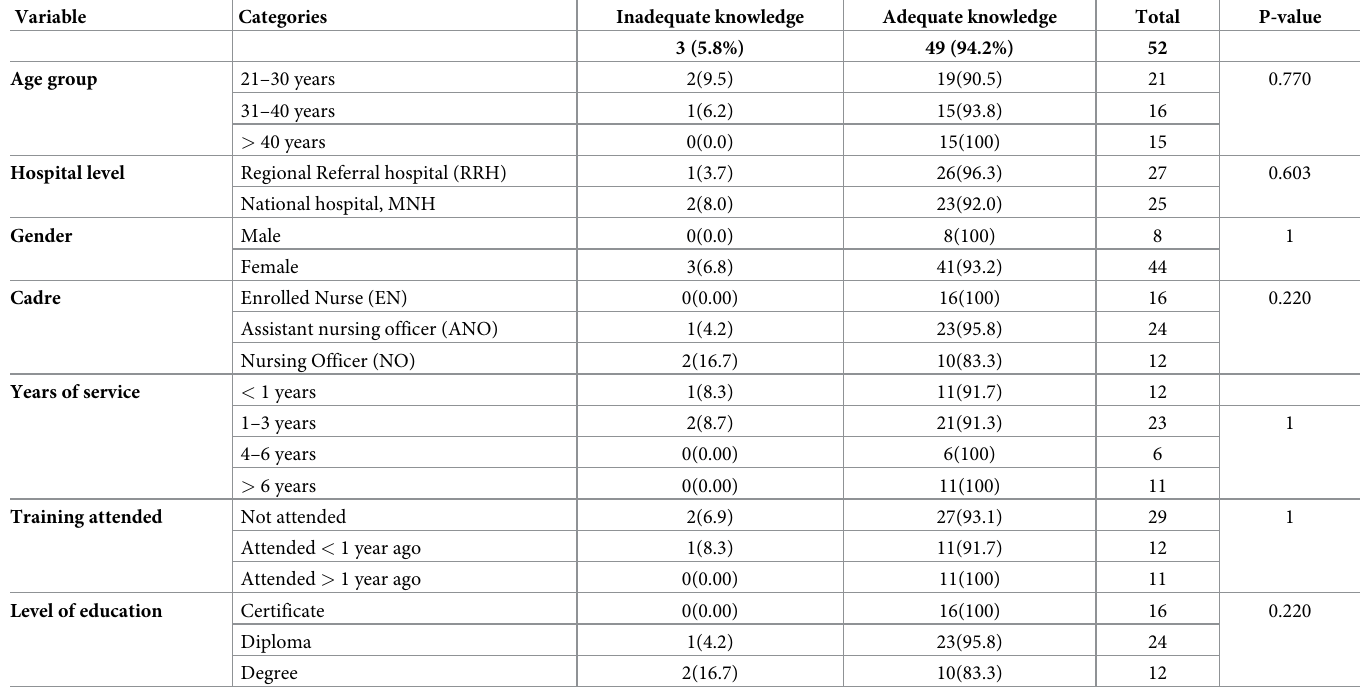
Table 1. Factors associated with nurse’s knowledge on essential newborn care.